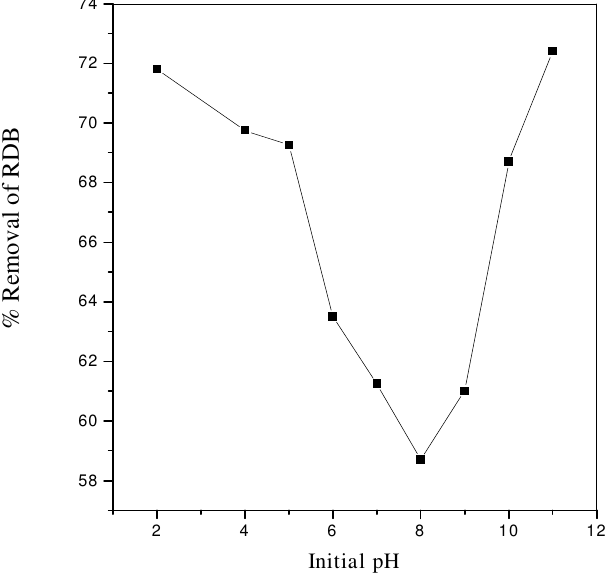
Figure 6 . Effect of initial pH on the adsorption of RDB by